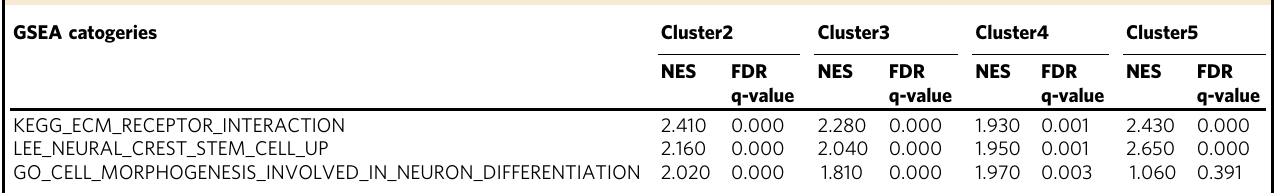
GSEA results of genes enriched in each cluster of melanoma cells (clusters 2 – 5) compared to the non-transformed McSCs (cluster1). All 4 tumor clusters (2 – 5) showed enrichment in the 3 key signatures observed by bulk RNA-seq (Fig. 5). NES normalized enrichment